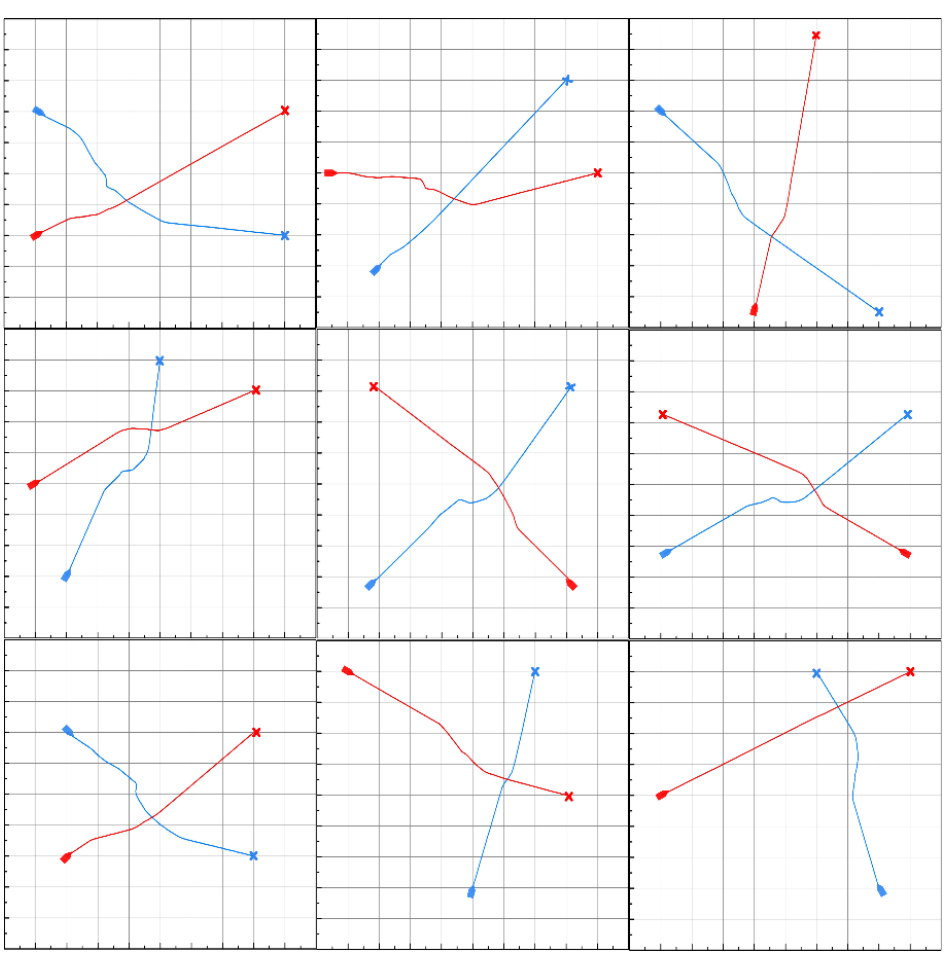
Figure 18. Additional two-ships encountering scenarios. (The simulation of the more two-ship encountering scenarios).